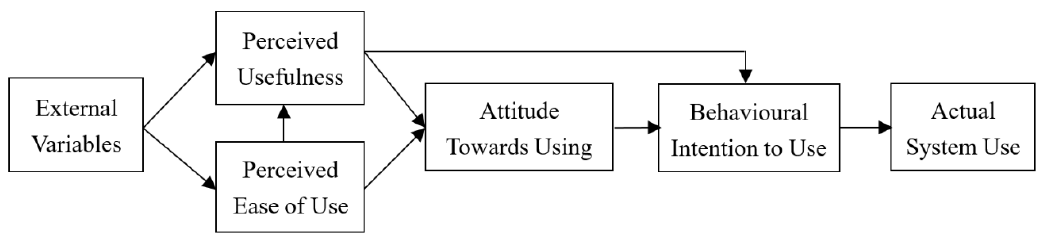
Figure 1. Technology Acceptance Model (TAM).